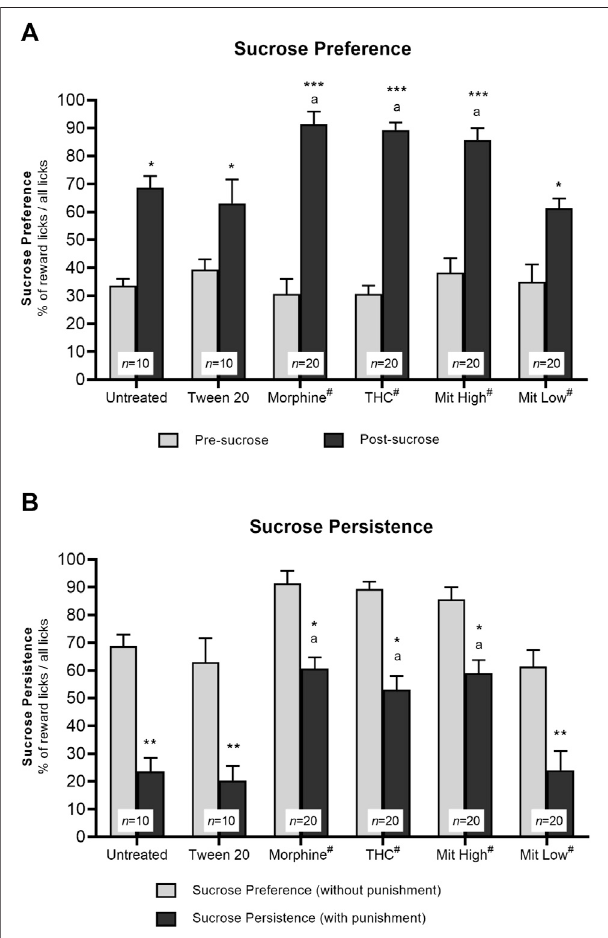
FIGURE 3 | Effects of drug intervention on preference for natural reward (sucrose) and persistence for sucrose seeking. (A) Preference for sucrose reward. The percentage of licks at the natural reward (10% sucrose) corner during the 2-day sucrose phase vs pre-sucrose (* p < 0.05, ** p < 0.01, *** p < 0.001 vs pre-sucrose; a: p < 0.05 vs Tween 20; ns (cid:1) p > 0.05 vs morphine;two-wayrepeatedmeasuresANOVAwith post-hoc Tukeytest). (B) Persistence of sucrose seeking. The percentage of reward licks when paired with air-puff punishment measured during the 3-day phase vs without air- puffs. * p < 0.05; ** p < 0.01 vs reward licks without punishment; a: p < 0.05 vs Tween 20 (two-way repeated measures ANOVA with post-hoc Tukey). # includes animals from drug only and drug + receptor antagonist groups (i.e., each group n (cid:1) 10).